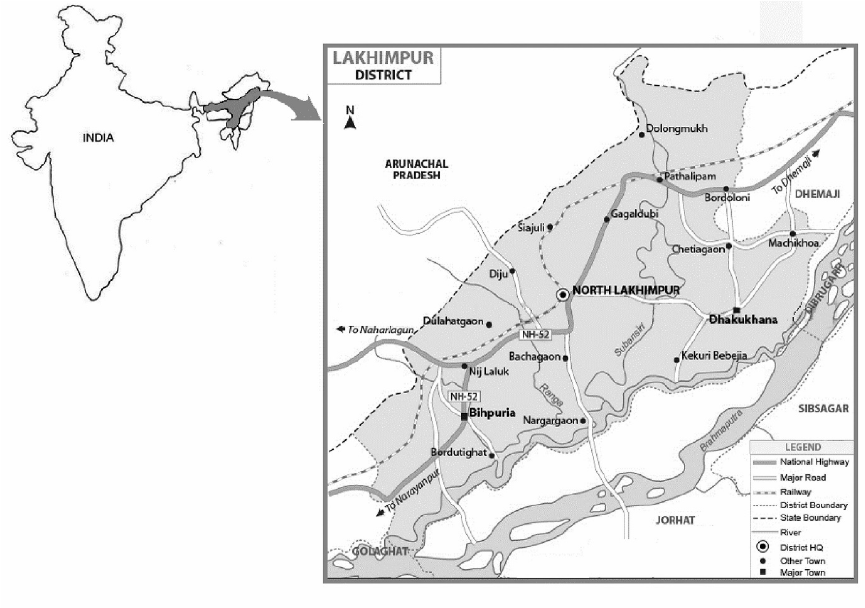
Fig. 1. Map of Lakhimpur district, Assam,